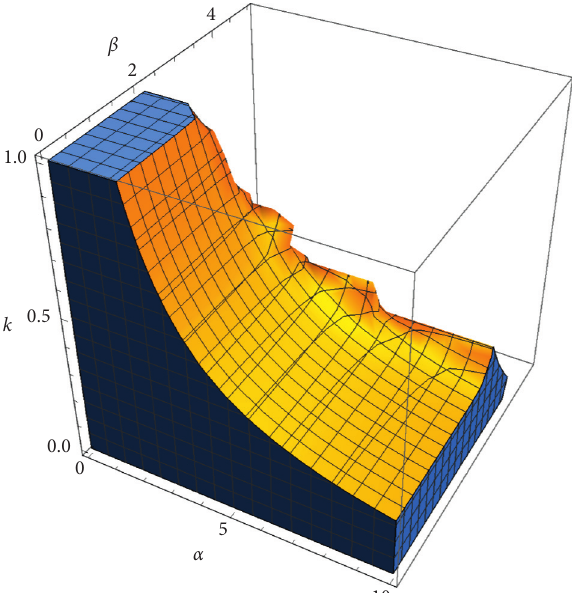
Figure 6: The stable region of the collective bargaining system.